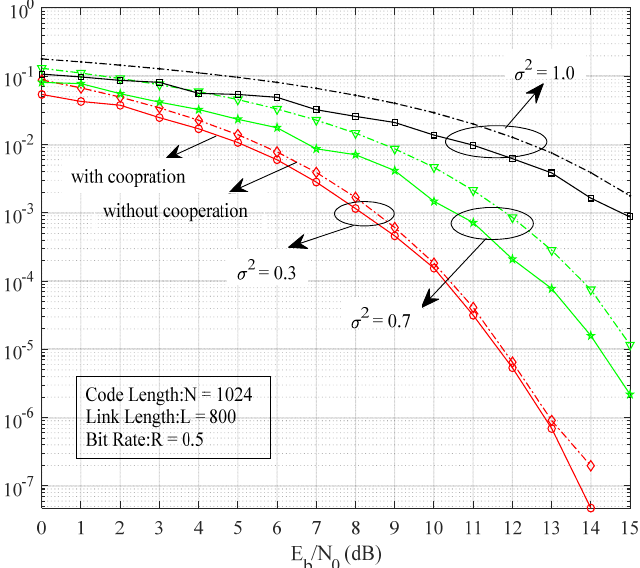
Figure 3. BER of cooperative FSO communication system and direct link under different turbulence intensity.